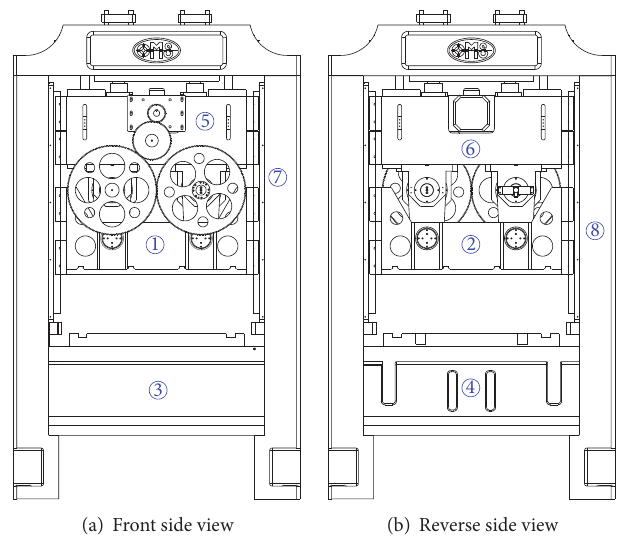
Figure 13: Arrangement of accelerometers on the punching